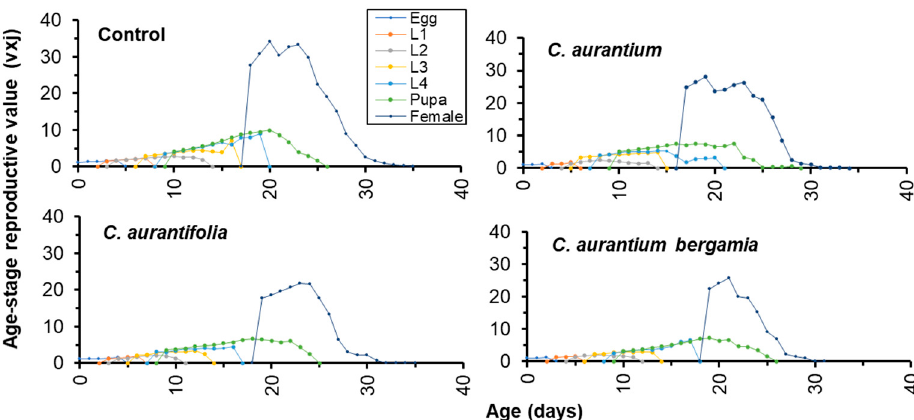
Figure 5. Age-stage reproductive value (vxj) of Tuta absoluta treated with LC 50 Citrus aurantifolia , Citrus aurantium and Citrus aurantium bergamia EOs and only acetone (control).